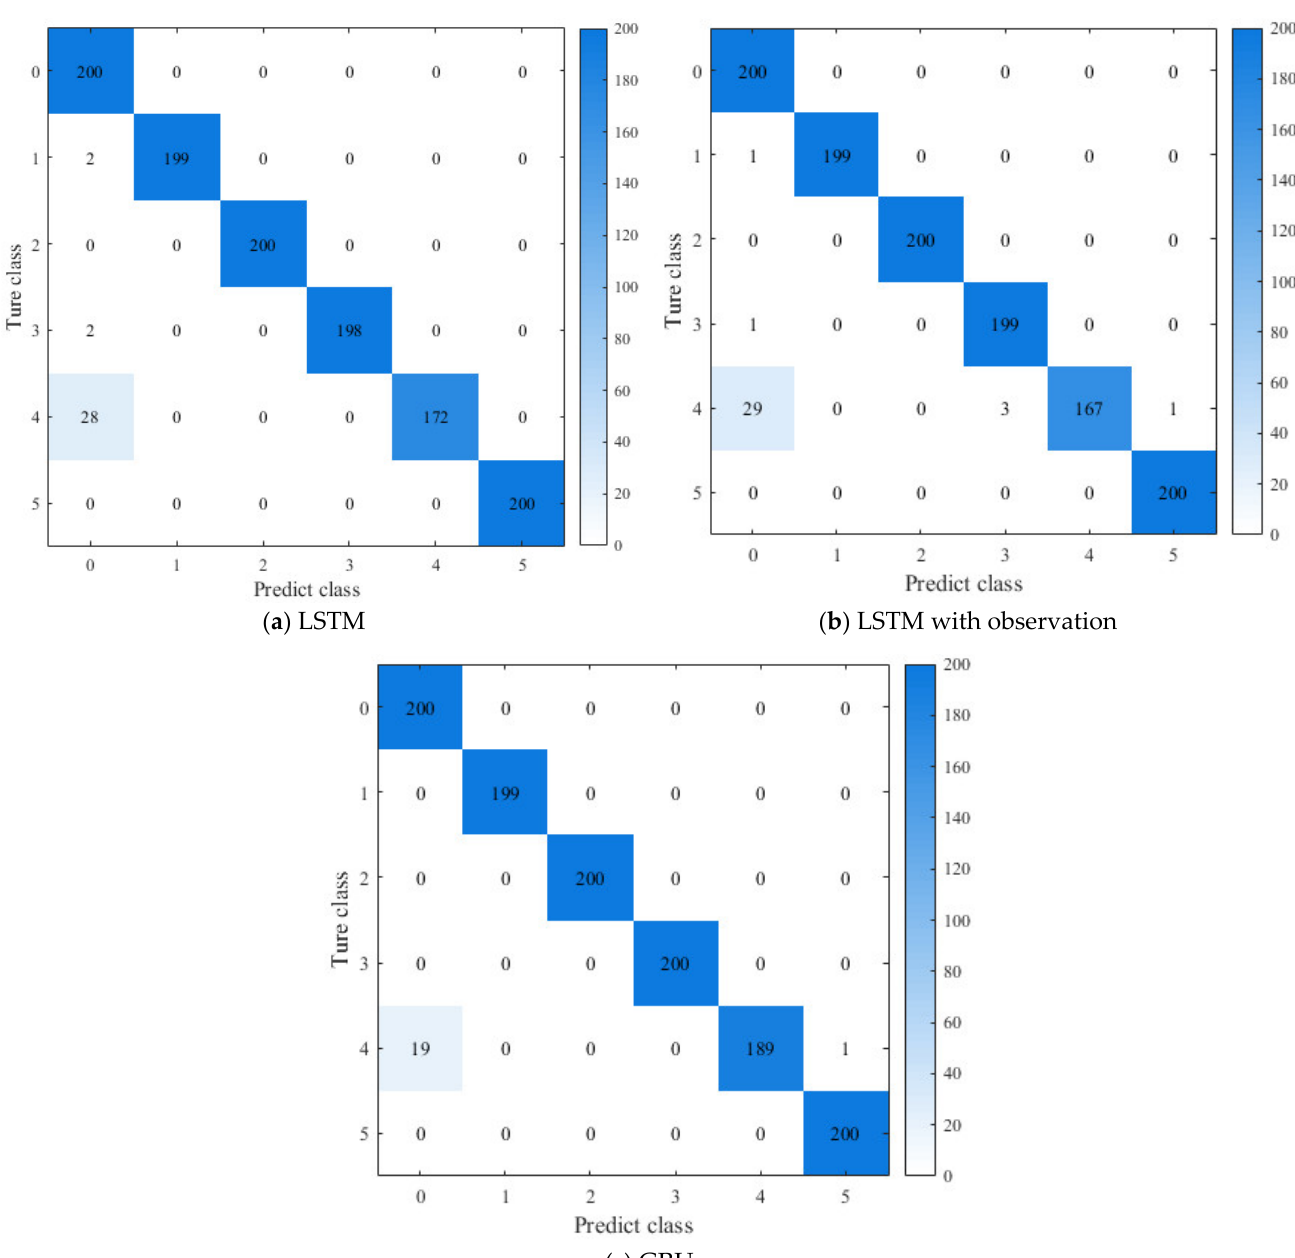
Figure 9. The confusion matrix of the three different structures of LSTM. Table 6. Simulation results of the three LSTM